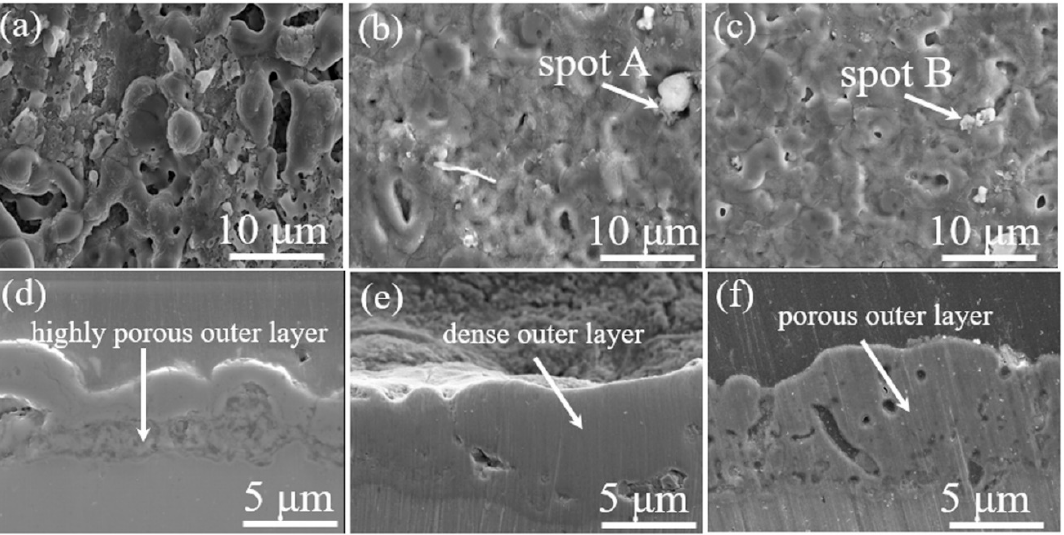
Figure 1. Images of the surface and cross-section for the ( a , d ) S0 sample, ( b , e ) S5 sample, and ( c , f ) S10 sample.